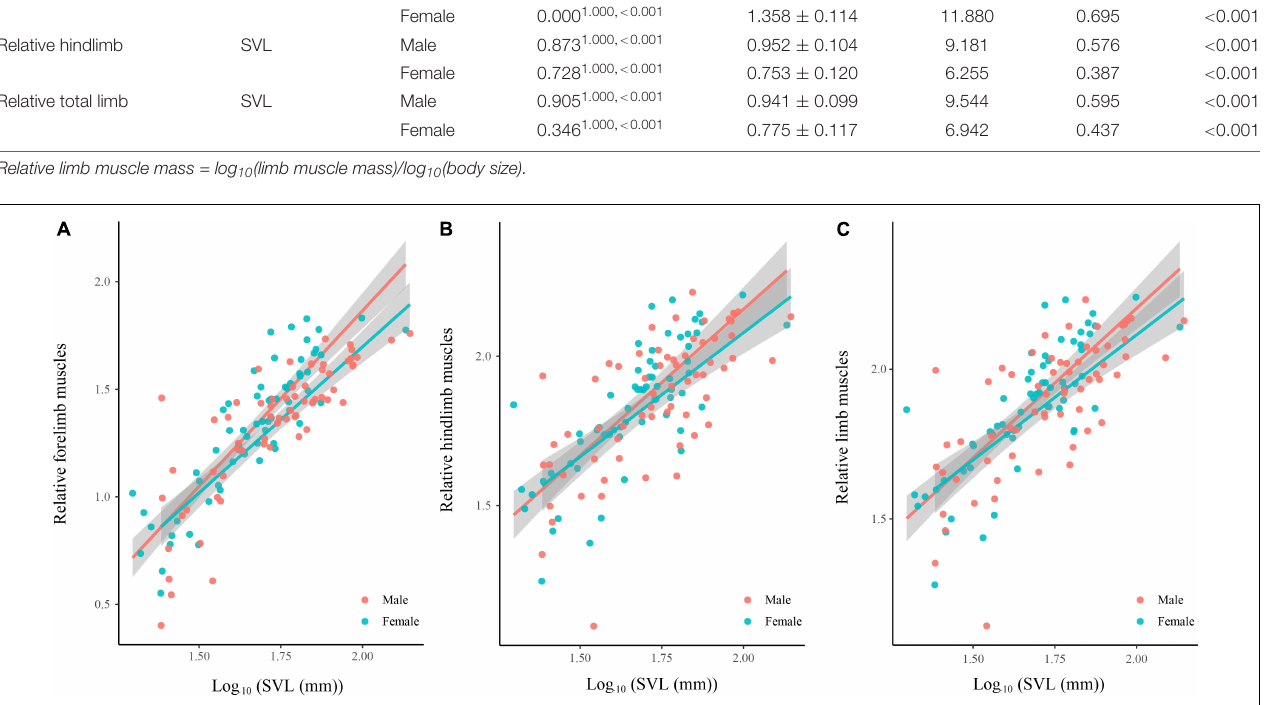
FIGURE 2 | Relative limb muscle mass [forelimb (A) , hindlimb (B) , and total limb (C) ] regressed on body size (SVL) among species of anurans. Relative limb muscle mass = log 10 (limb muscle mass)/log 10 (SVL). Each dot is a